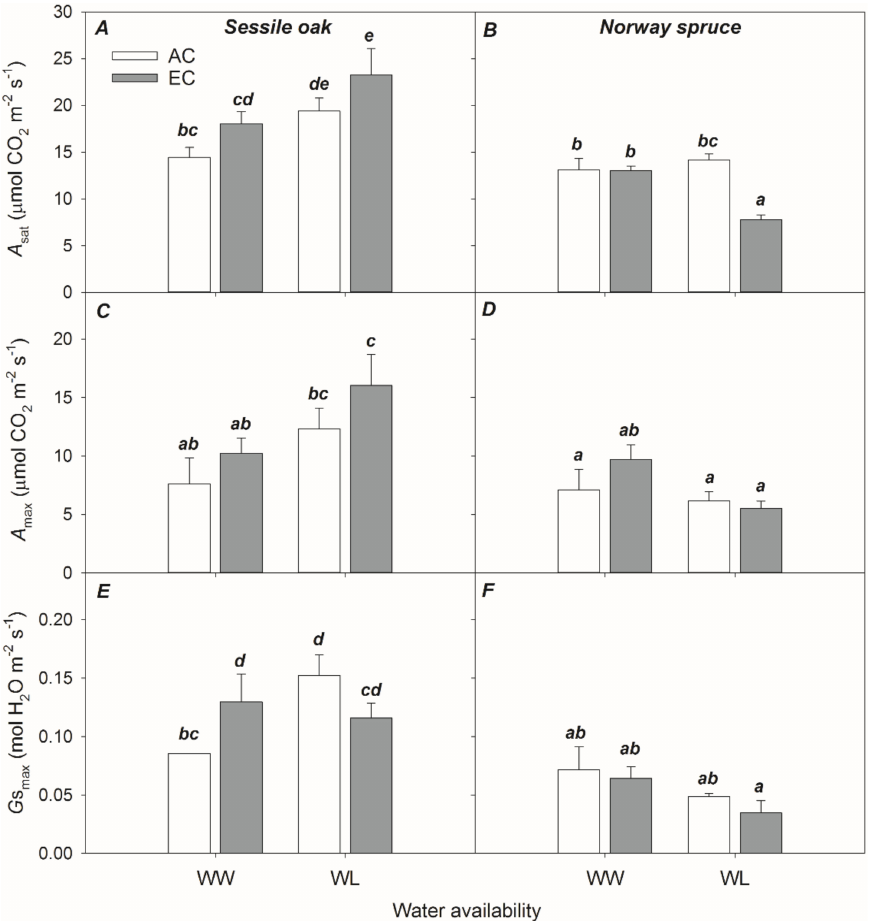
Figure 3. Effect of CO 2 concentration and water availability on CO 2 assimilation capacity ( A sat ; ( A , B )), light-saturated CO 2 assimilation rate at growth [CO 2 ] ( A max ; ( C , D )) and light-saturated stomatal conductance ( G Smax ; ( E , F )) in sessile oak (left) and Norway spruce (right). The measurements were done during the second growing season of cultivation under manipulated conditions: AC—ambient CO 2 concentration (~400 µ mol CO 2 mol –1 ), EC—elevated CO 2 concentration (~700 µ mol CO 2 mol –1 ), WW—well-watered (regular watering of 20 mm per week during vegetation period), WL—water- limited (no irrigation for 5 weeks before the measurements). Means (columns) and standard devi- ations (error bars) are presented ( n = 3). Different letters indicate significant differences ( p ≤ 0.05) between means based on Tukey’s ANOVA post-hoc